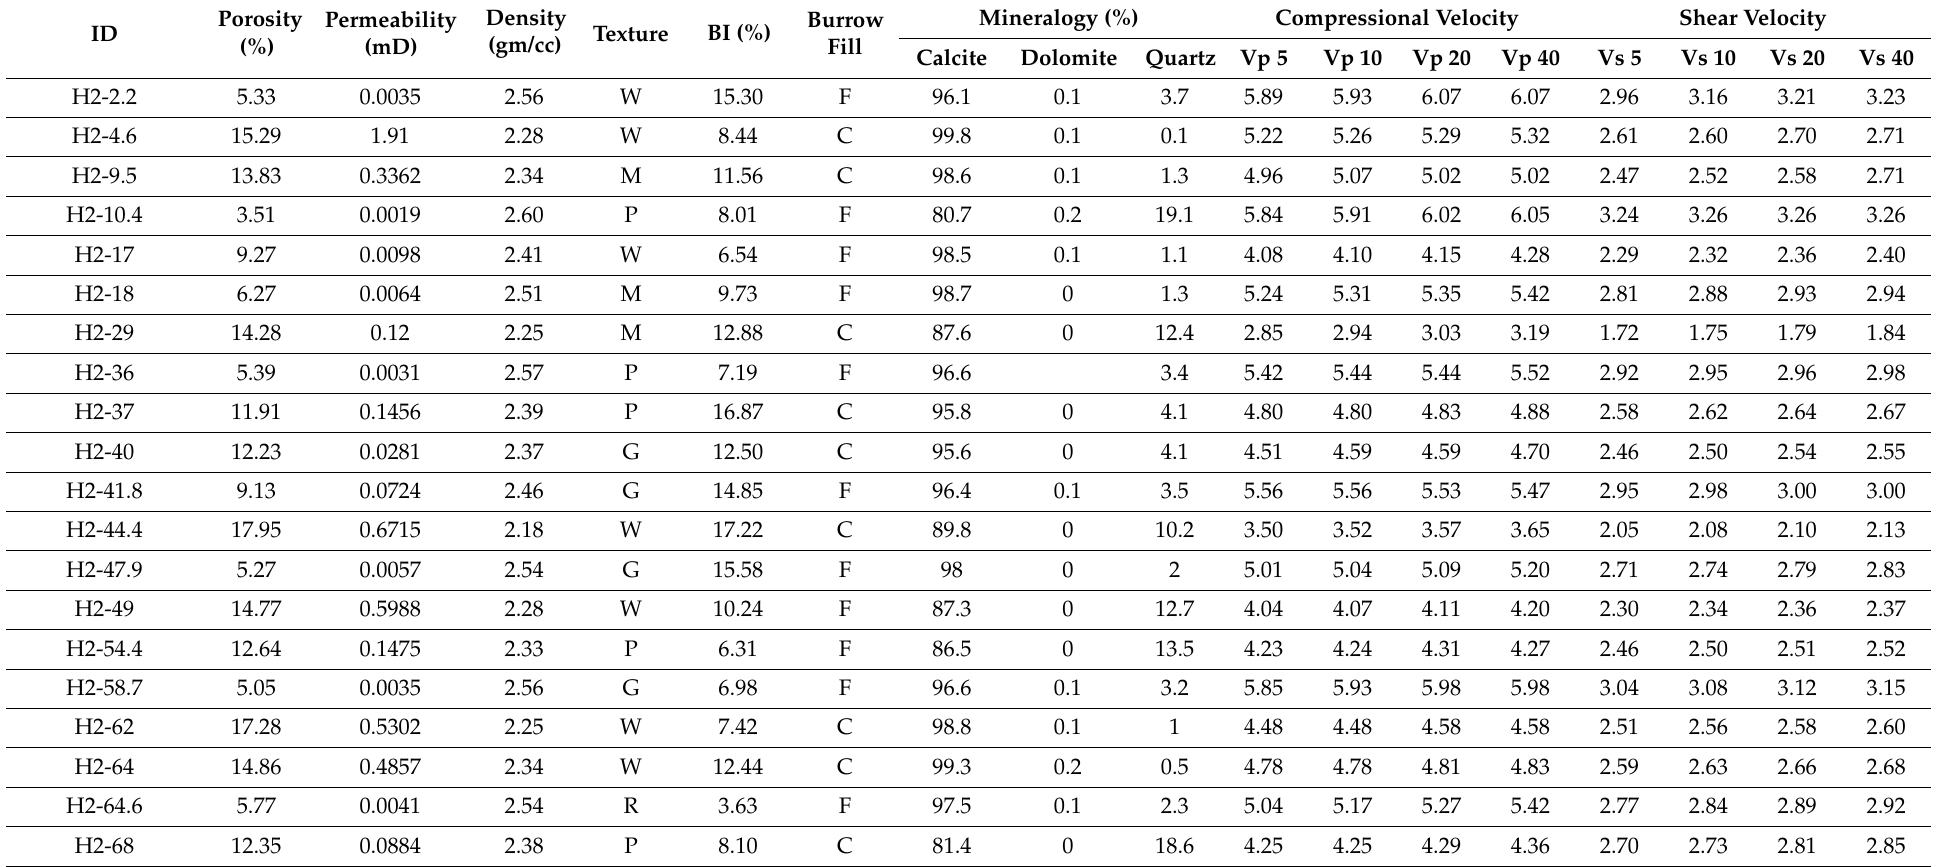
Table A1. Porosity, permeability, texture, bioturbation intensity (BI) in %, burrow fill, mineralogy, compressional and shear wave velocity of the studied samples. Texture; (M = Mudstone, W = Wackestone, P = Packstone, G = Grainstone, F = Framestone, R = Rudstone). Burrow Fill (F = Fine Fill, C = Coarse